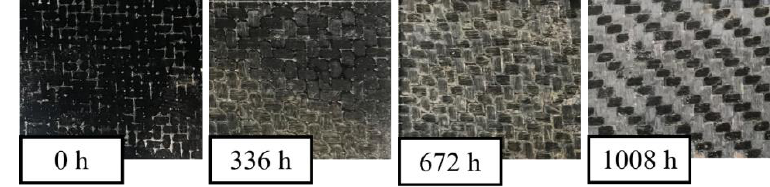
Figure 7. B-SFRP specimens subjected to different accelerated aging steps.